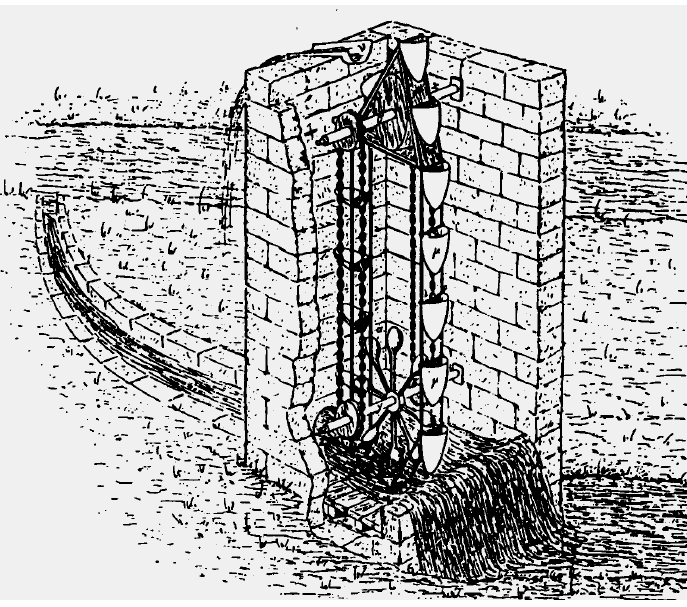
Figure 10. Philon’s paddle-wheel driven bucket-chain (adapted from